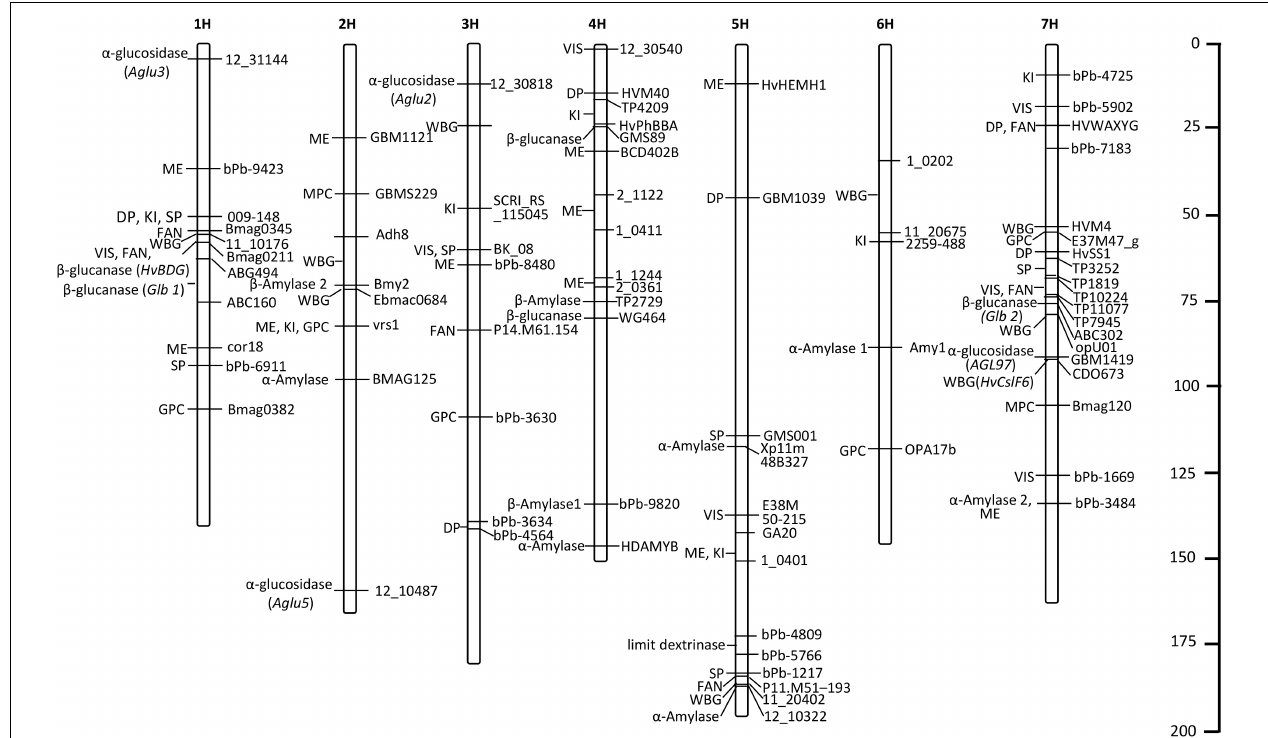
FIGURE 2 | The distributions of QTLs/genes accounting for high phenotypic variances. ME, malt extract; DP, diastatic power; VIS, wort viscosity; KI, kolbach index; FAN, free amino nitrogen; SP, soluble protein; WBG, wort β -glucan; MPC, malt protein content; GPC, grain protein